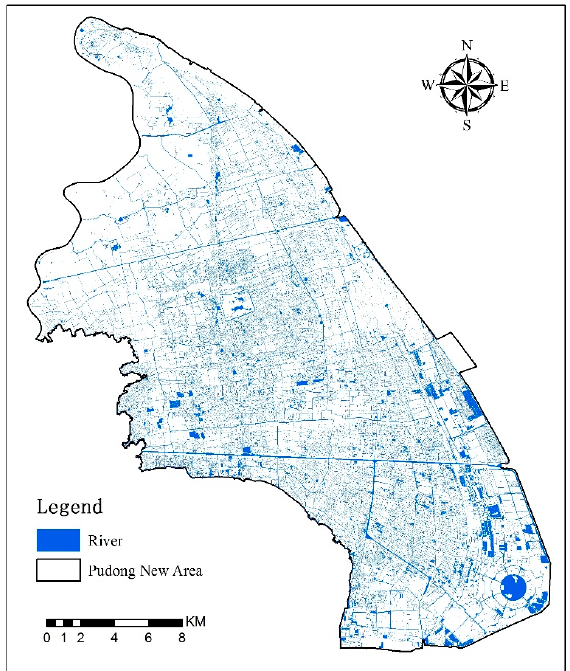
Figure 2. Distribution of the river system in the Pudong New Area.